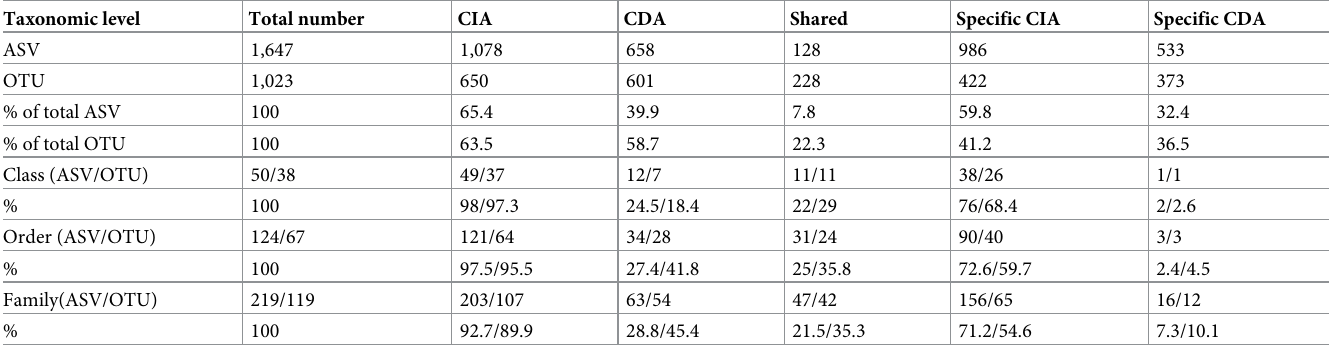
Table 1. Comparison of diversity in culture-dependent (CDA) and culture-independent (CIA) approaches, using ASV or OTU analysis. Taxonomic